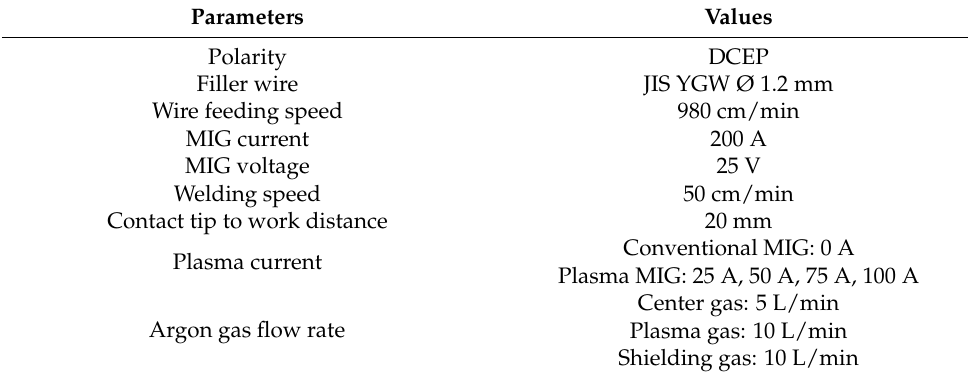
Table 3. Welding parameters.